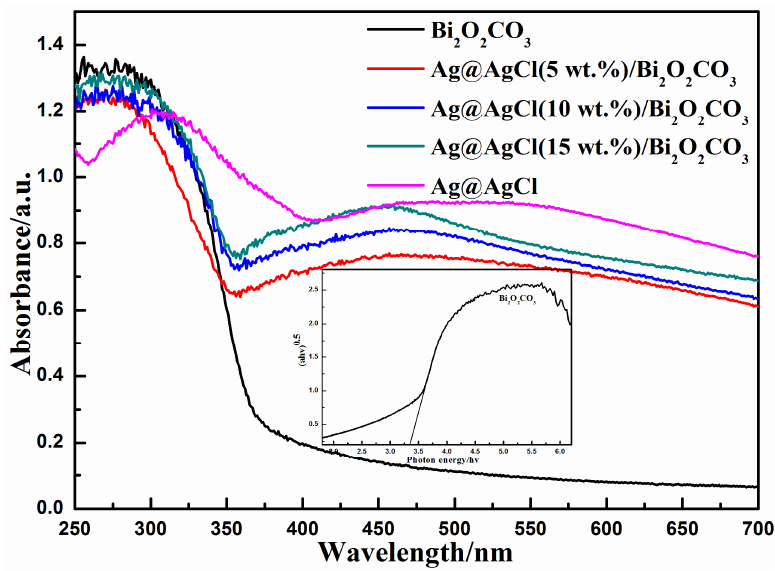
Figure 5. UV-vis diffuse reflectance spectrum (DRS) of as-prepared Bi 2 O 2 CO 3 , Ag@AgCl and a series of Ag@AgCl/Bi 2 O 2 CO 3 composites (inset: band gap determination of pure Bi 2 O 2 CO 3 samples).